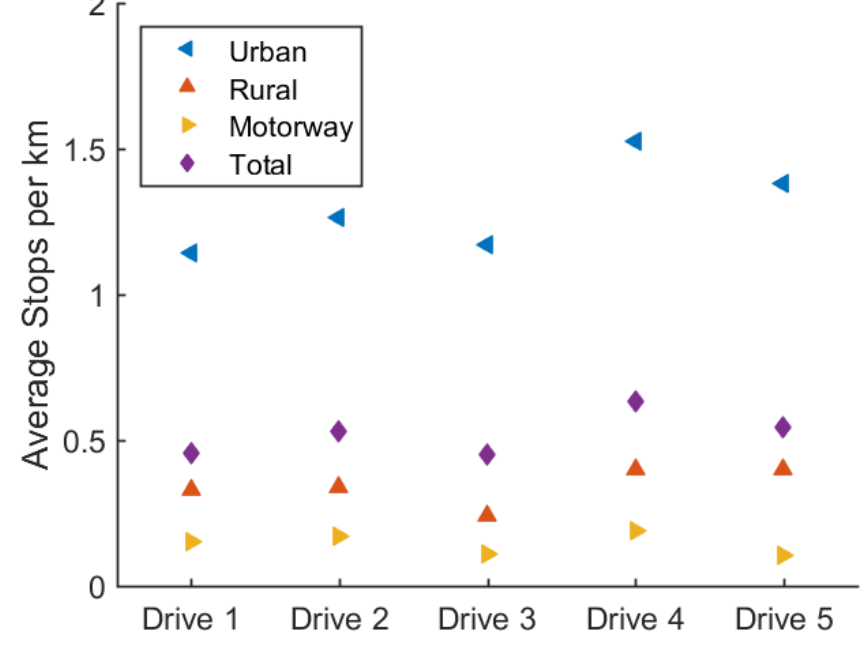
Figure 9. Average number of stops per kilometer for each section of the drive, by topographical